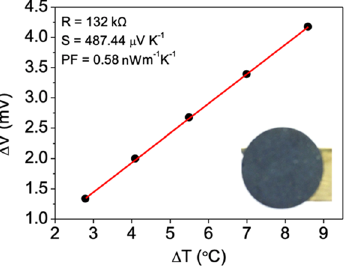
Fig. 6 Thermo-voltage vs. temperature difference plot measured from an Mg 2 Si pellet. From the linear fit slope, the Seebeck coefficient was determined and enabled the calculus of the power factor, being both values